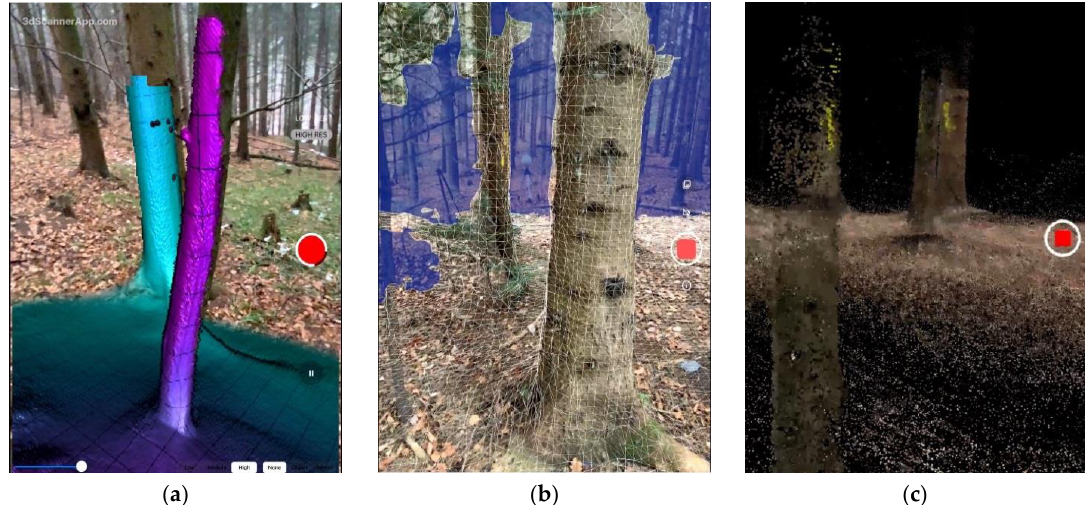
Figure 3. ( a ) Data acquisition with 3D Scanner App. ( b ) Data acquisition with Polycam. ( c ) Data acquisition with SiteScape.